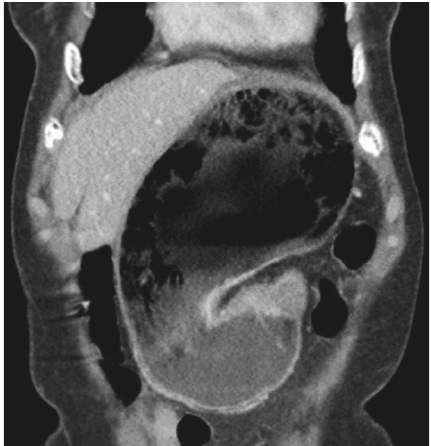
Figure 3: CT of abdomen and pelvis with contrast showing a markedly distended abdomen without focal wall thickening. The J- shaped stomach is rotated along its long axis, displaying a gastric volvulus. Fluid, consistent with blood, is seen tracking along the paracolic gutters and the